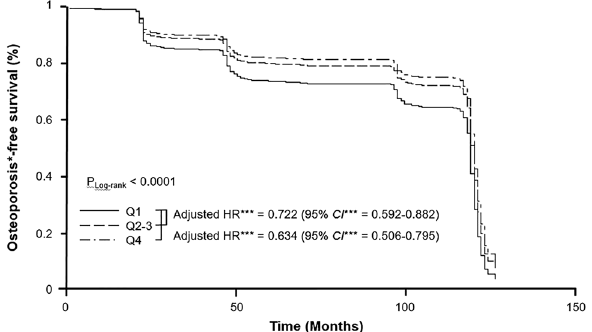
Figure 3. The impact of dietary salt intake on osteoporosis-free survival. Q1 had a poor osteoporosis-free survival rate compared with other groups, but there was no significant difference in adjusted HR between Q2–3 and Q4 (adjusted HR* = 0.878, 95% CI* = 0.735–1.050). *Calculated by Cox-proportional hazard model using age, sex, and smoking history as covariates and body mass index, waist circumference, systolic BP, diastolic BP, hemoglobin, sodium, corrected calcium, hemoglobin A1c, eGFR, triglyceride, LDL-cholesterol, UACR, and urine potassium/creatinine ratio as predictors. HR, hazard ratio; CI, confidence